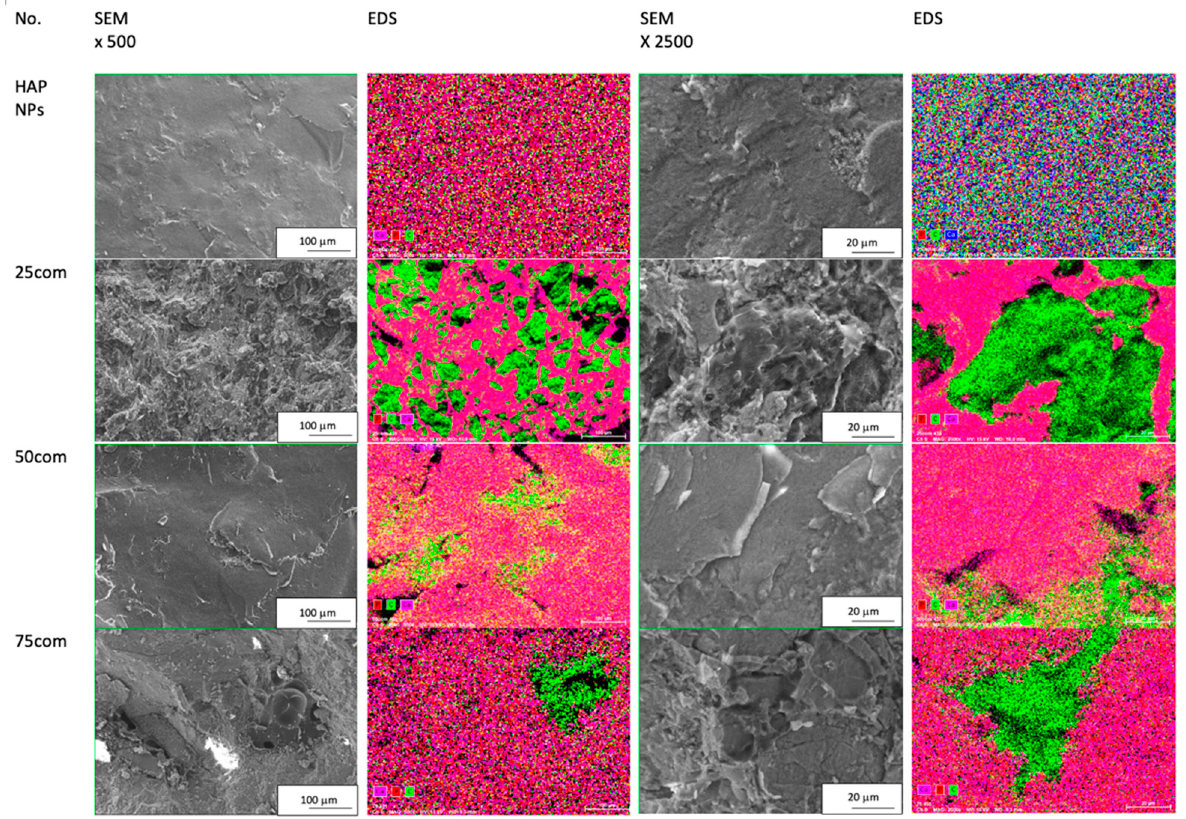
Figure 5. Collection of SEM images; EDS mapping for HAP NPs sample and 25com, 50com, and 75com composites. Table 2. Contact angle of PLLA and HAP NPs samples, and composite samples obtained by two- stage forming.